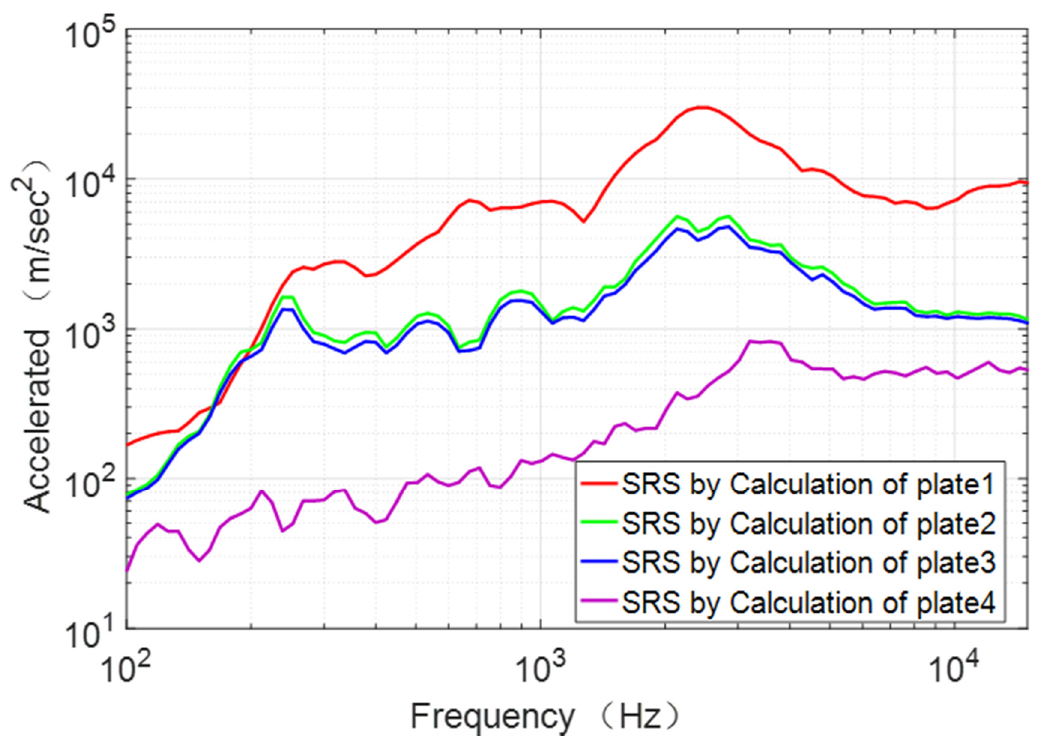
Figure 9. The SRS result of spacecraft structures by hybrid FE-SEA method.